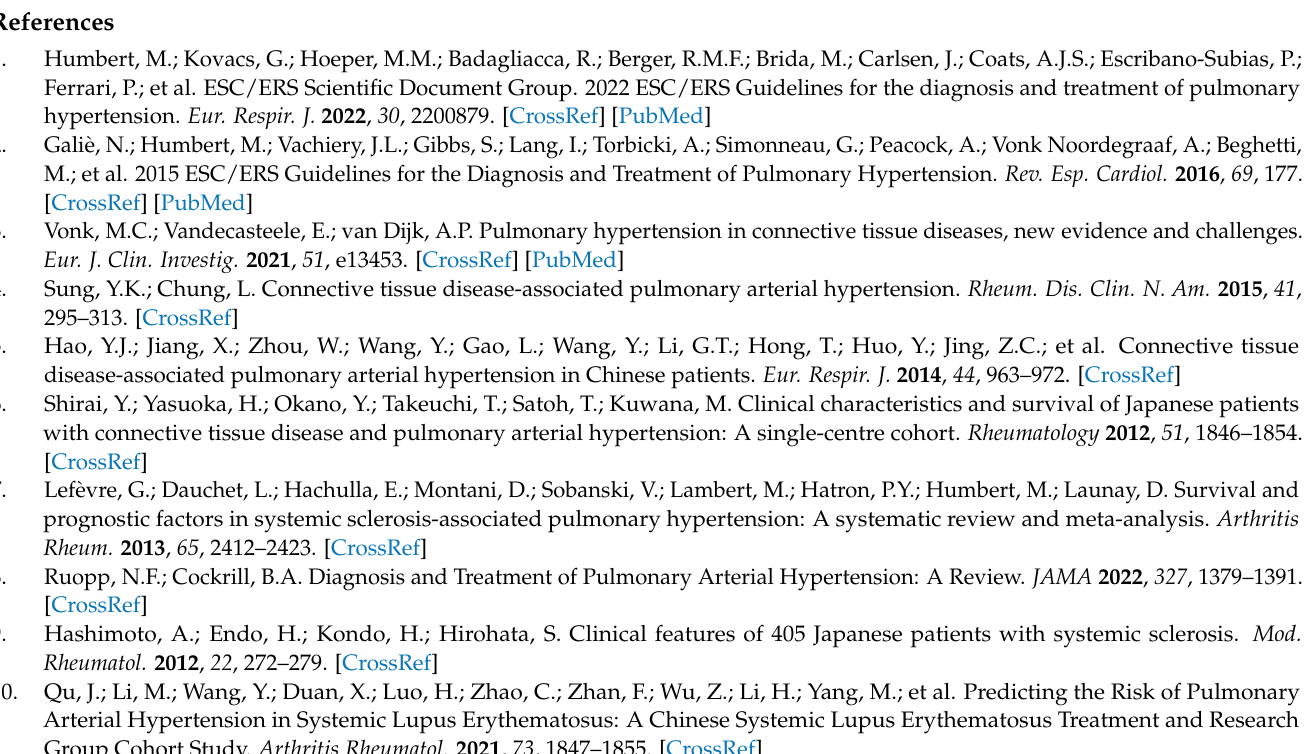
Table S2: Characteristics of included studies; Table S3: Quality evaluation outcomes; Table S4: Results of subgroup analysis of prognostic factor analysis; Figure S1: Sensitivity analysis of risk factor